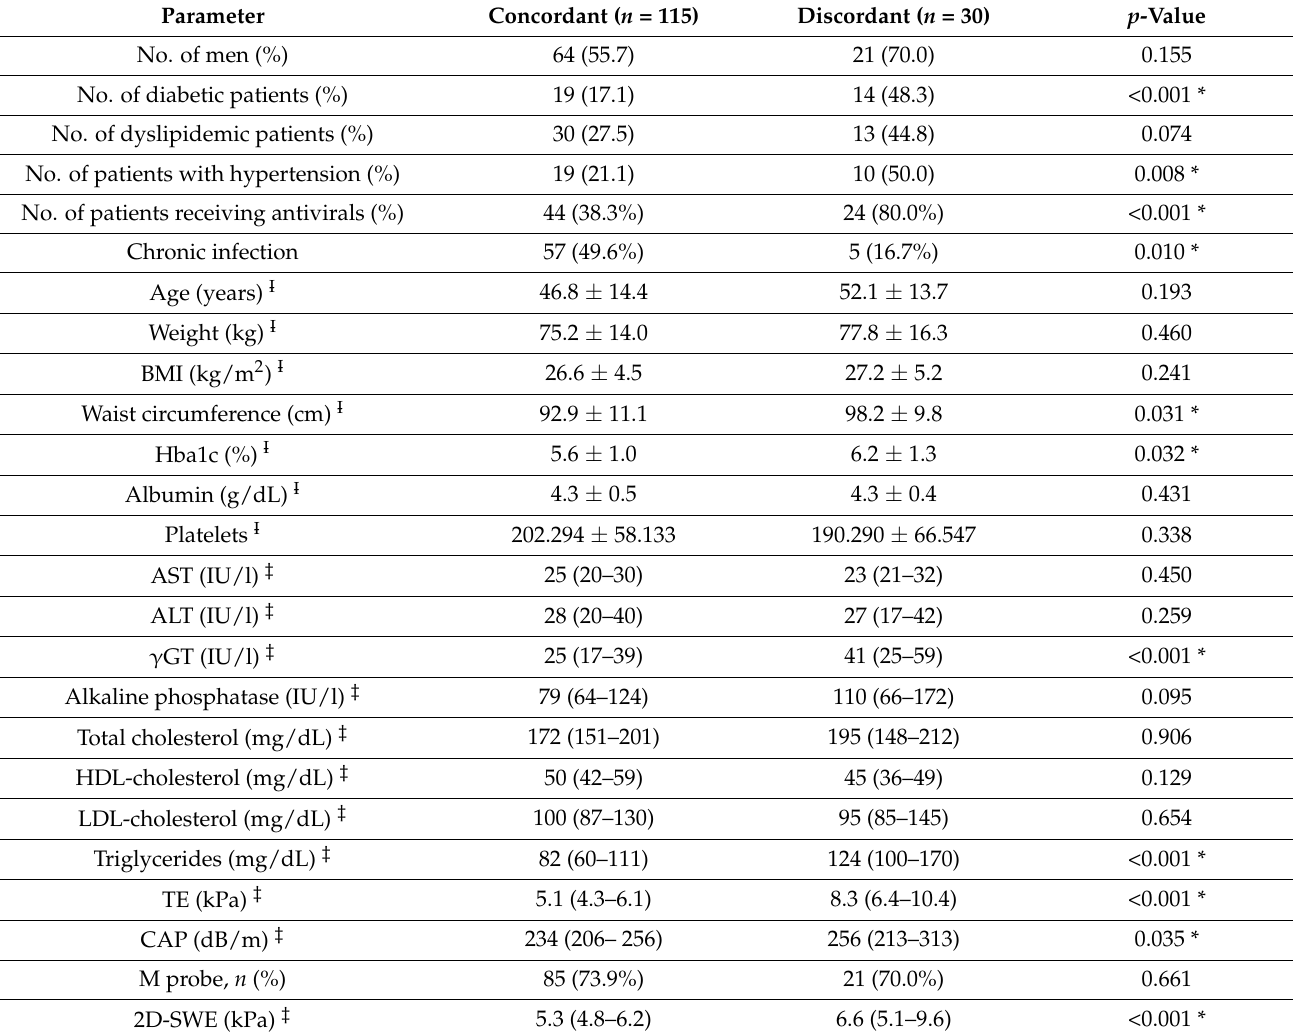
Table 5. Summary of demographic data and blood test and elastography results for patients with concordant and discordant exams between TE and